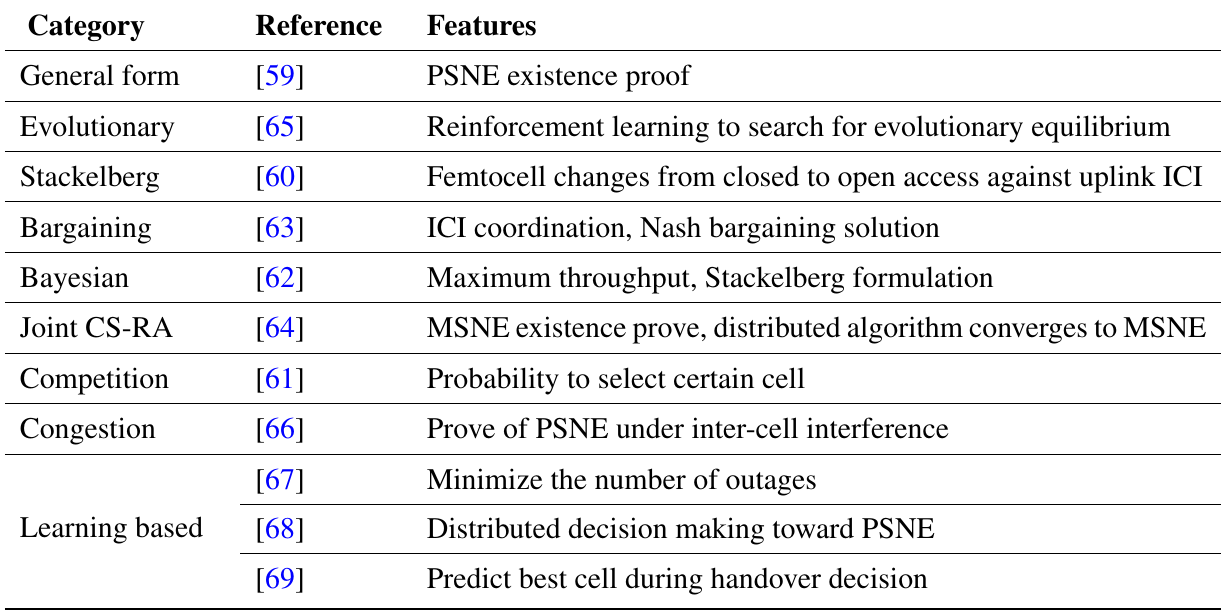
Table 2. Summary of the CS game between